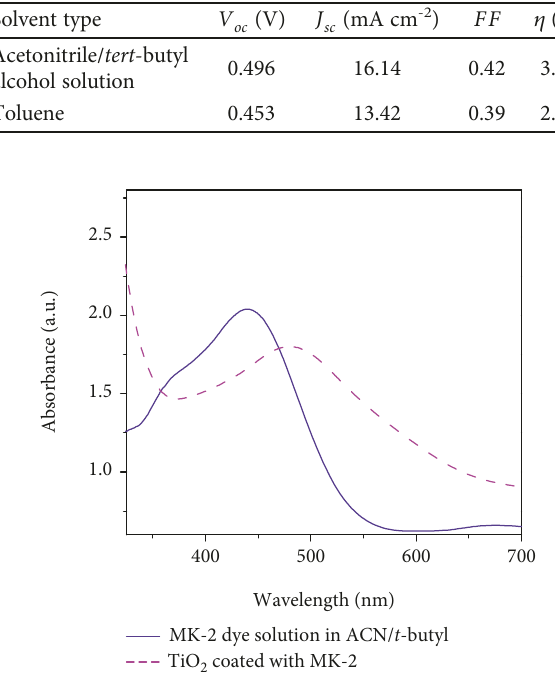
Figure 6: Absorption spectra of the MK-2 dye in acetonitrile/ tert - butyl alcohol (solid line) and dye absorbed in TiO